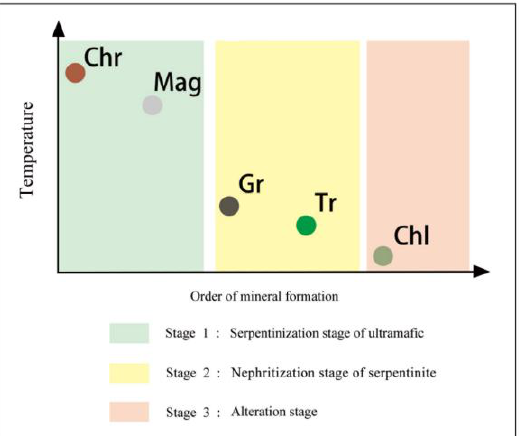
Figure 14. Sequence diagram of mineral formation in chatoyant green nephrite from Ospinsk, Russia. Chr: chromite; Mag: magnetite; Gr: graphite; Tr: tremolite; Chl: chlorite.